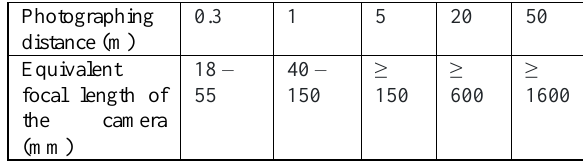
Table 1. The dependence of the optimal equivalent focal length